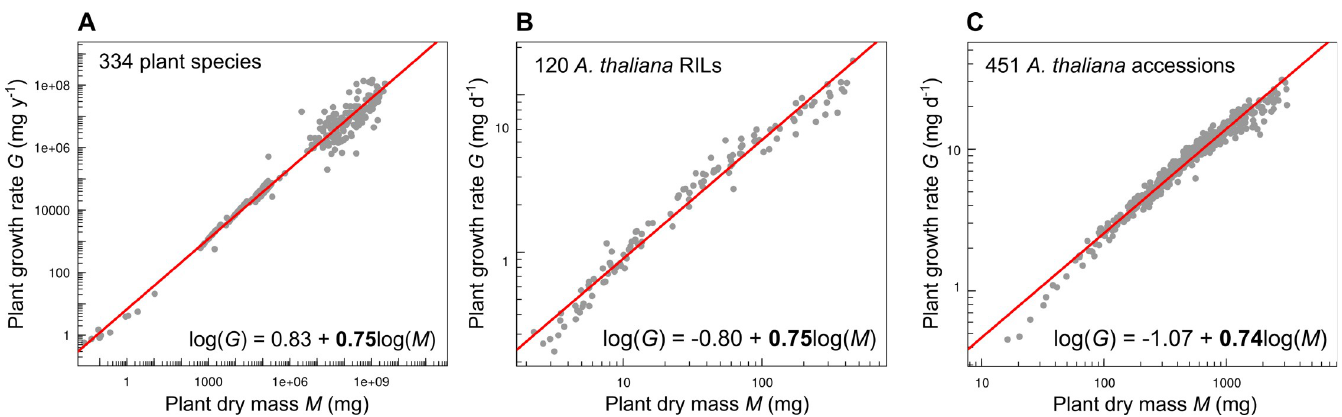
Fig 2. Allometric relationships in plants. (A) Log–log relationship between annual growth rate G and plant dry mass M across 334 plant species (data from [66]). (B) Log–log relationship between daily growth rate G and plant dry mass M across 120 RILs of A . thaliana (data from [60]). (C) Log–log relationship between daily growth rate G and plant dry mass M across 451 natural accessions of A . thaliana (data from [31]). Red lines and equations were fitted with SMA regressions. RIL, recombinant inbred line; SMA, standard major axis.